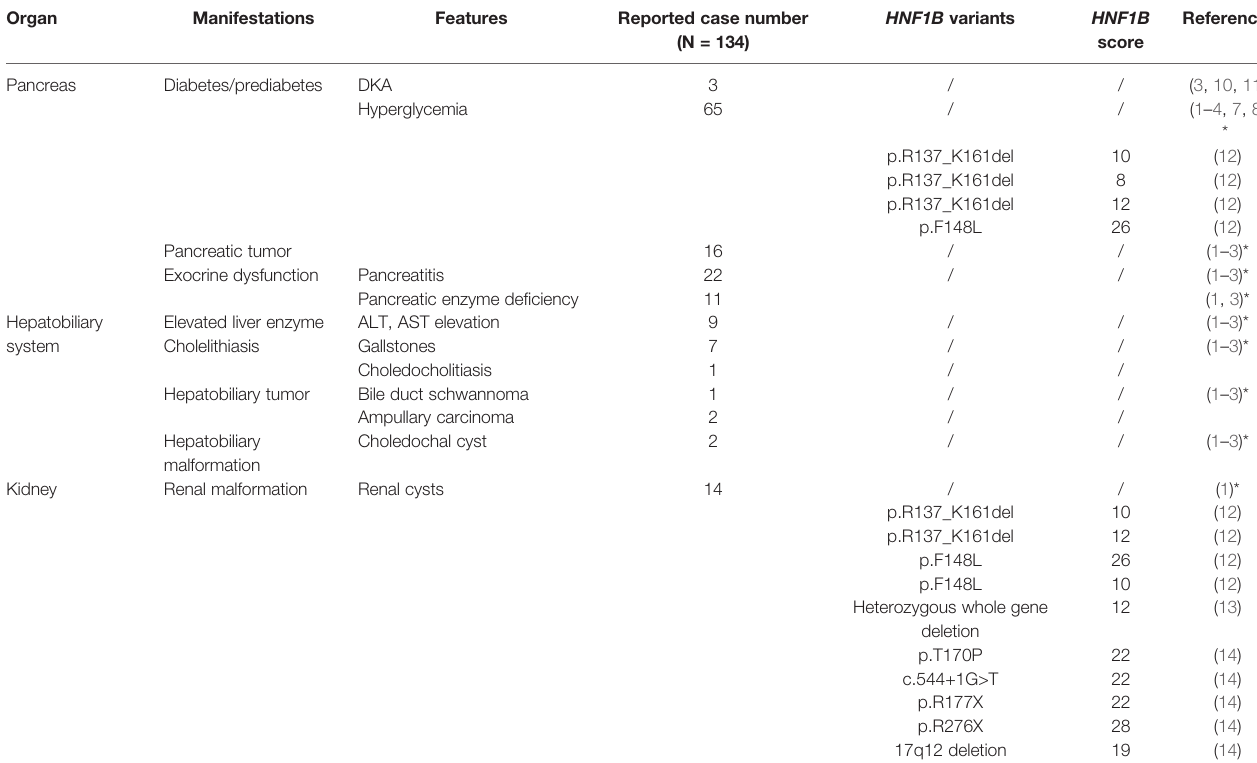
TABLE 2 | Concomitant manifestations and HNF1B variants of